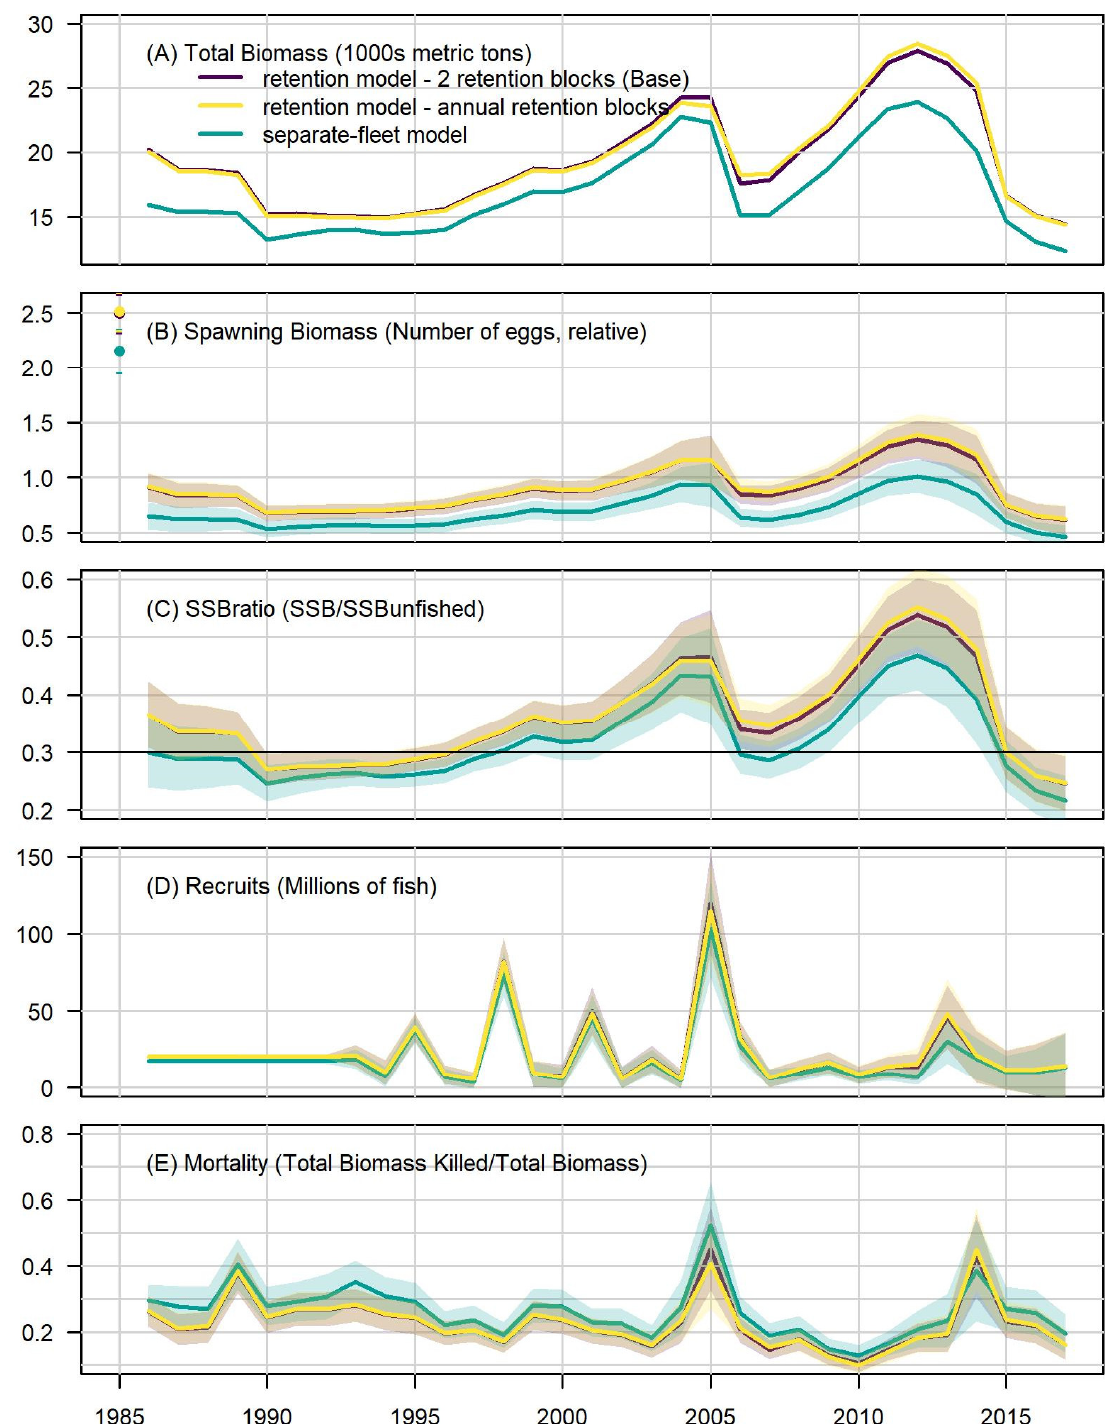
Figure 5. Derived quantities from the Gulf red grouper models where retention was modeled using two time blocks (base model; purple), annual time blocks (yellow), or where discards were modeled as a separate-fleet (teal). ( A ) Total biomass. ( B ) Unfished (top left, dots with dashed lines indicative of 95% confidence intervals) and annual spawning stock biomass (SSB). ( C ) SSB ratio, defined as the ratio of SSB to unfished SSB (horizontal line identifies target value of 0.3). ( D ) Recruitment. ( E ) Mortality in terms of exploitation, defined as the proportion of total biomass killed to total biomass (with red tide mortality included in 2005 and 2014). The 95% confidence intervals surrounding each curve are indicated by the relevant color.